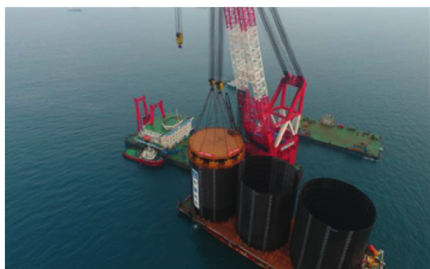
Figure 24: Clamping of steel cylinder.